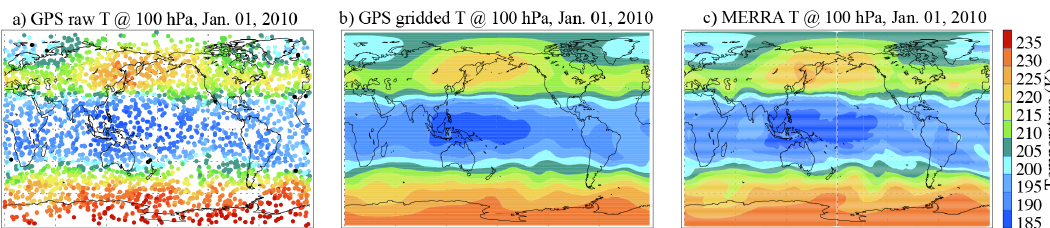
Figure 1. Comparison of temperatures from raw GPS (a) , gridded GPS (b) , and MERRA temperature (c) at 100hPa on 1 January 2010.